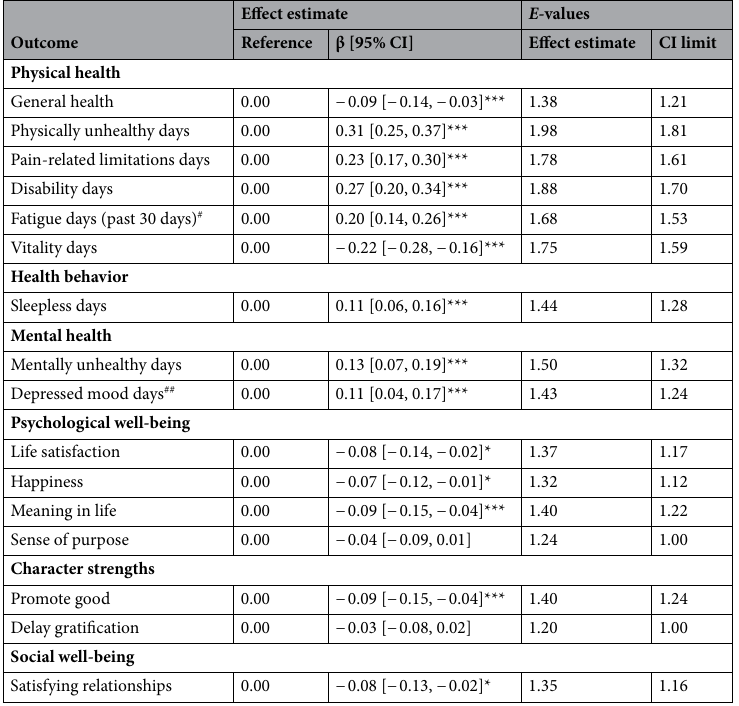
analyses include cutoffs for p -values both before and after Bonferroni correction. For reasons outlined in Study 1, we do not use Bonferroni correction as the primary lens for interpreting the results. Results for the associations of overall suffering assessed at T1 with each of the subsequent health and well- being outcomes assessed at T2 are presented in Table 3. Overall suffering was associated with subsequently worse health and well-being on at least one outcome in each domain (small to large in magnitude), including all indices of physical health (βs = − 0.09 to 0.31, p s ≤ 0.001), sleepless days (β = 0.11, p < 0.001), both indices of mental health (βs = 0.11 to 0.13, p s ≤ 0.001), the psychological well-being indices of life satisfaction, happiness, and meaning in life (βs = − 0.09 to − 0.07, p s ≤ 0.017), the character strength of being oriented toward promoting good (β = − 0.09, p < 0.001), and satisfying relationships (β = − 0.08, p = 0.006). Sense of purpose (psychological well-being domain) and delay gratification (character strengths domain) were the only two outcomes for which